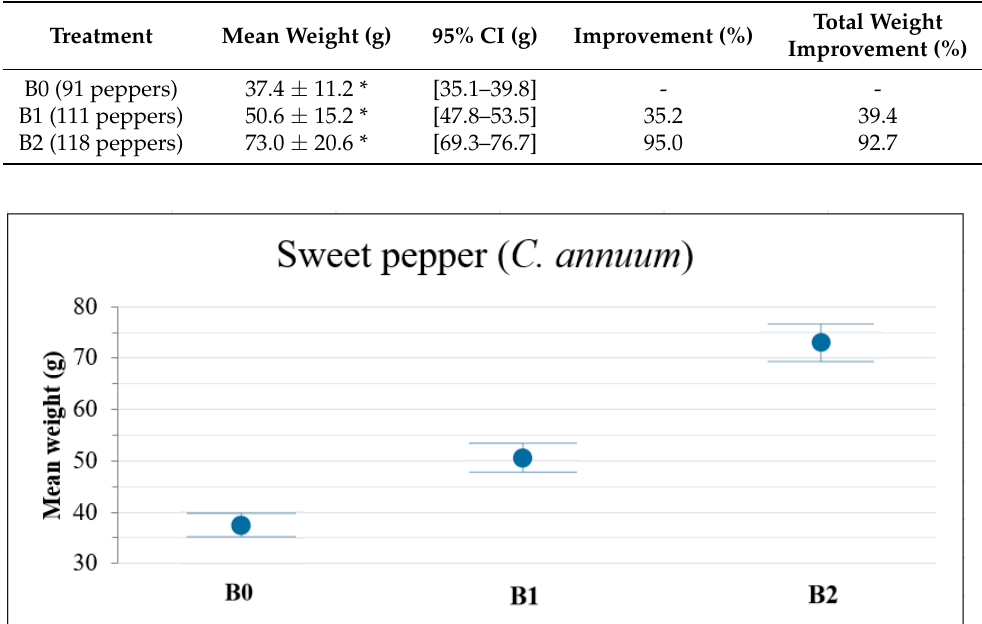
Table 6. Mean sweet pepper weight in each treatment, expressed as mean ± standard deviation, with 95% CI denoting the confidence interval at p = 0.05. * Significant difference p < 0.01.